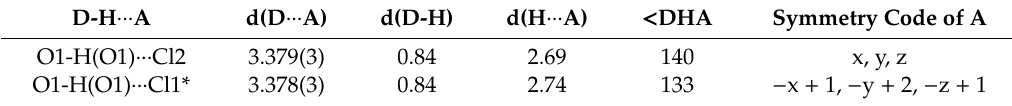
Table 5. Hydrogen bonding interactions (Å, deg) in the crystal structure of {[CdCl 2 (phpaoH)]} n ( 2 ). D-H ···